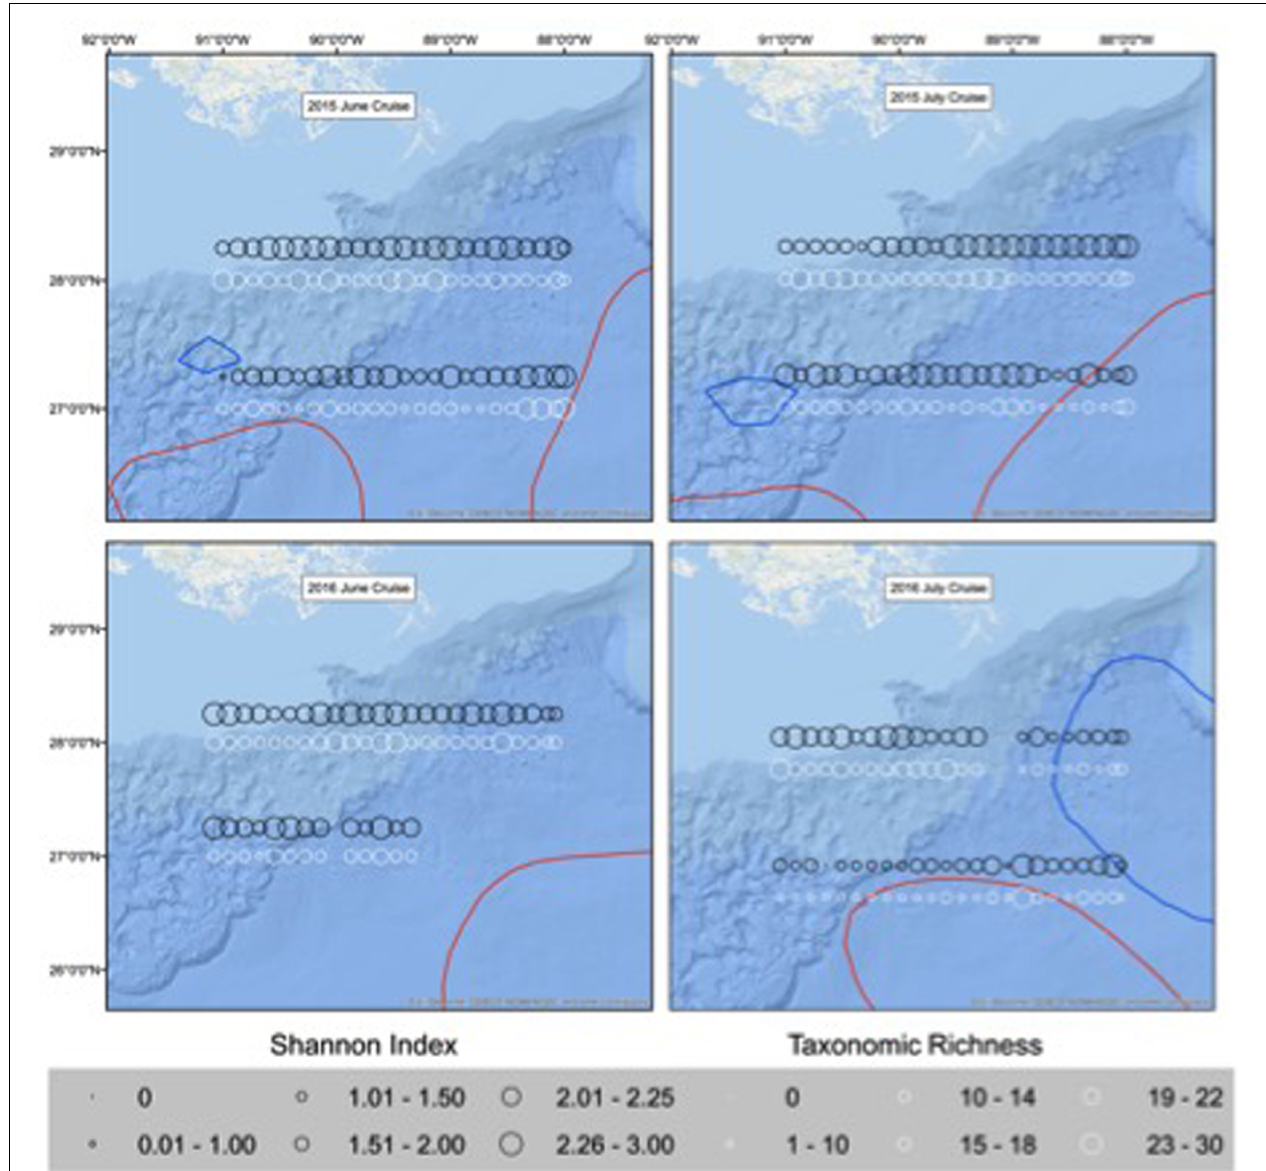
FIGURE 3 | Shannon index ( H’ ; black) and taxonomic richness ( T F ; white) of larvae collected in June and July of 2015 and 2016 in the Northern Gulf of Mexico. Circles represent diversity of larvae per station. Location of the Loop Current and warm eddies is represented in red and cold core eddies are represented in blue.